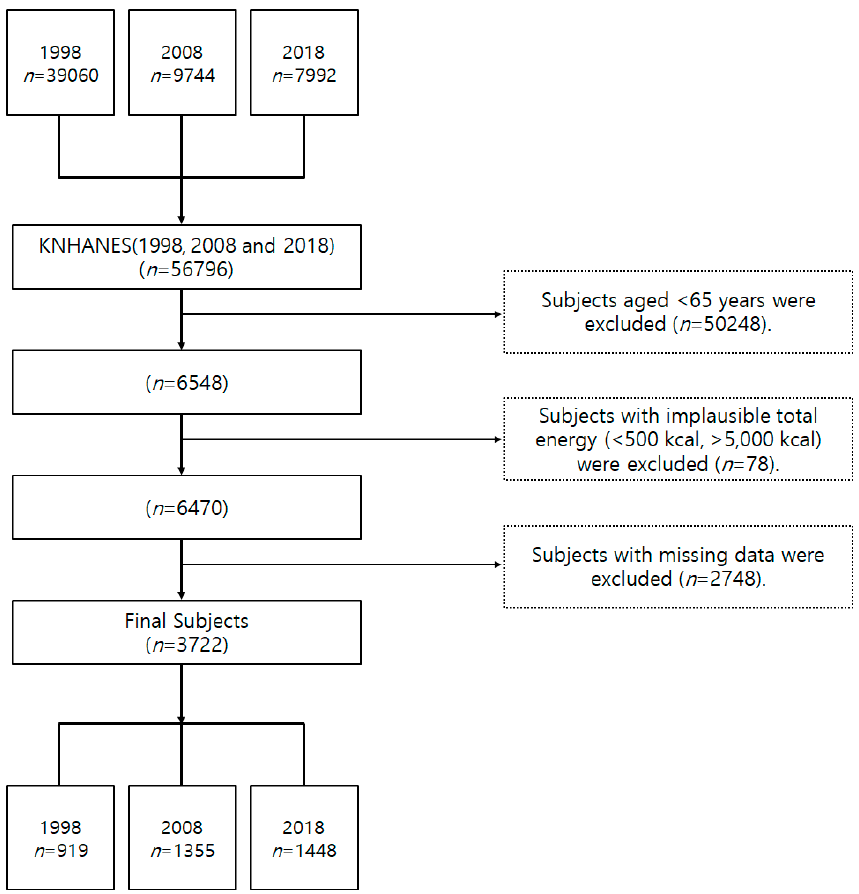
Figure 1. The flow chart regarding subject samples of this study.